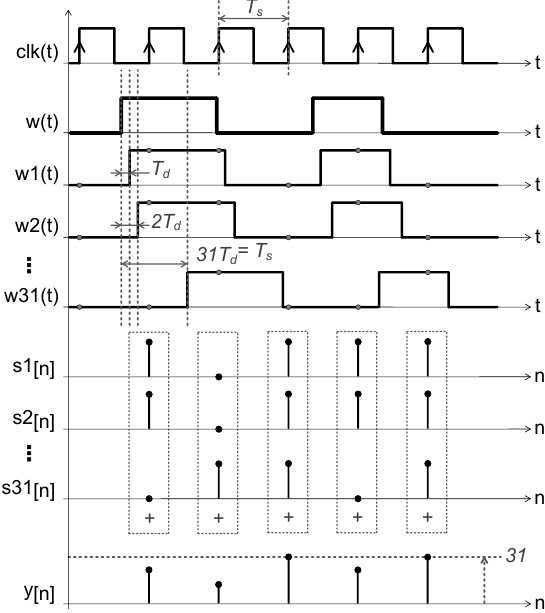
Figure 5. Chronogram of digital signals in the single-ended channel configuration.